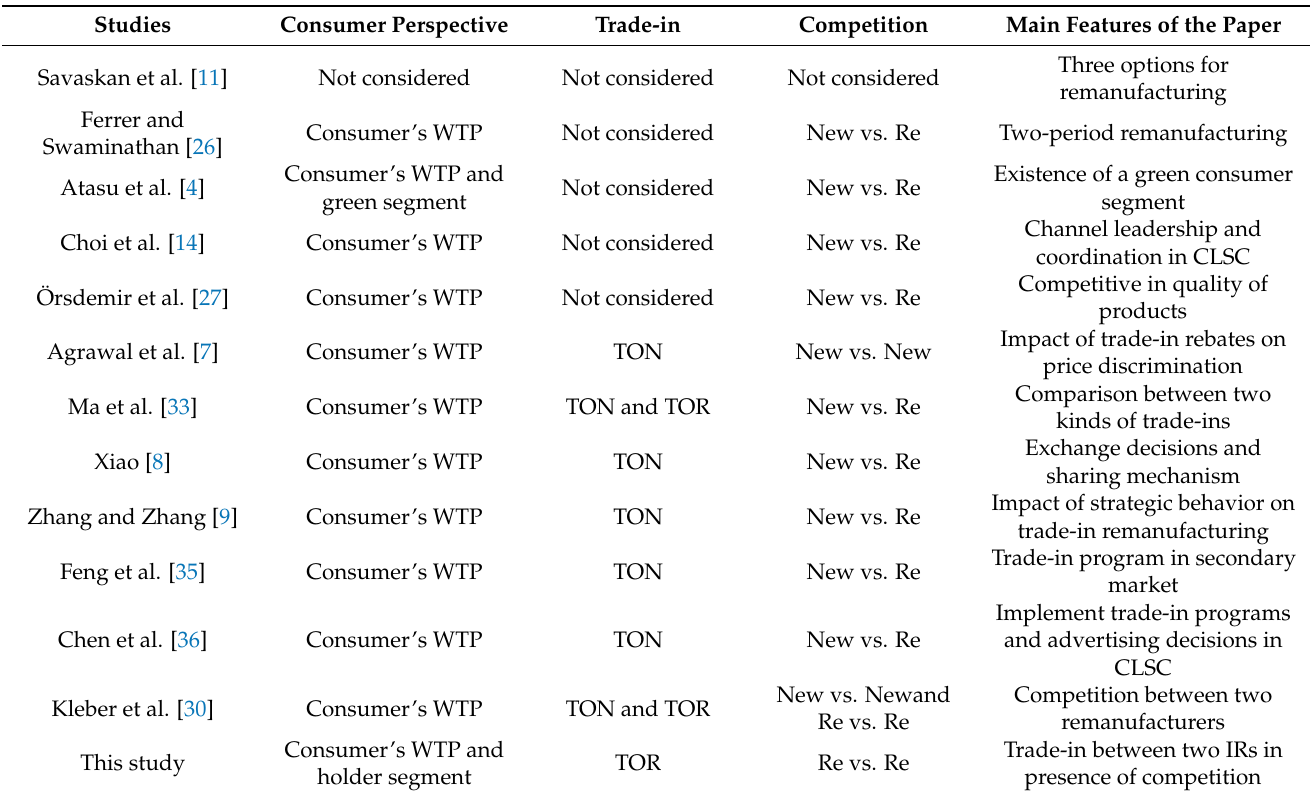
Table 1. Comparison of this study and related